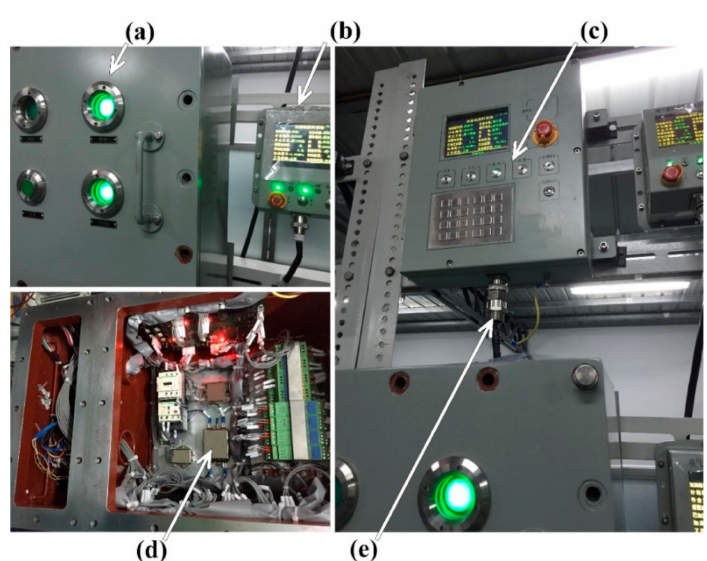
Figure 13. Refueling control system equipment: ( a ) MCU of the refueling system, ( b ) DCU of the near-machine, ( c ) DCU of the refueling system, ( d ) inside of the MCU, and ( e ) RS485 communica- tion